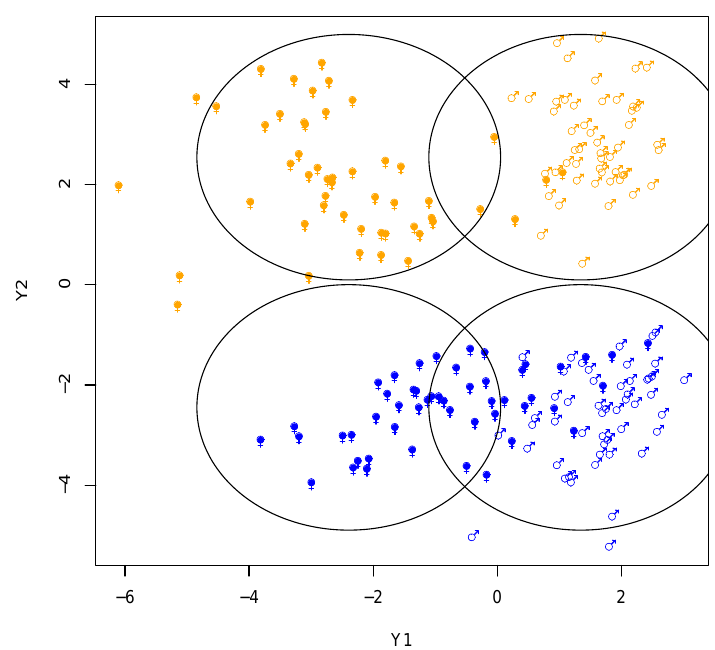
Figure 10. Scatter plots of the clustering subspace on the crabs data for K 1 = K 2 = 2, 95% isodensity is given for each component resulting of the Cartesian